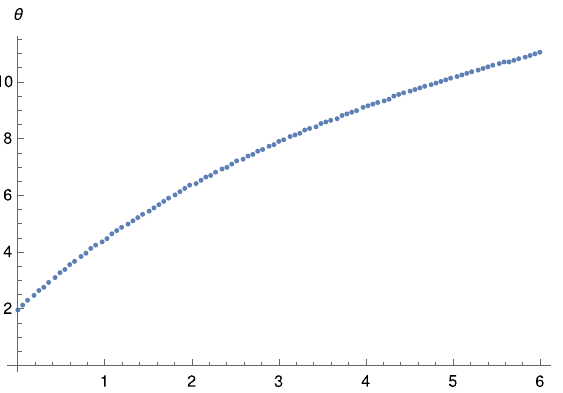
Fig. 2 Coordinates of the non-gaussian fixed point for different values of the dimensionless mass m 2 k